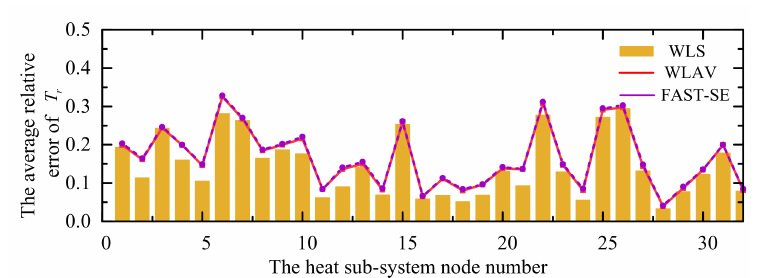
Figure 8. The average relative error e x ( % ) of T s .